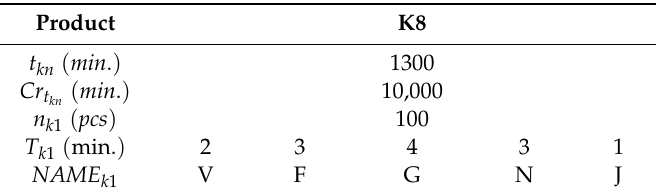
Table 4. The input values for the product K8.